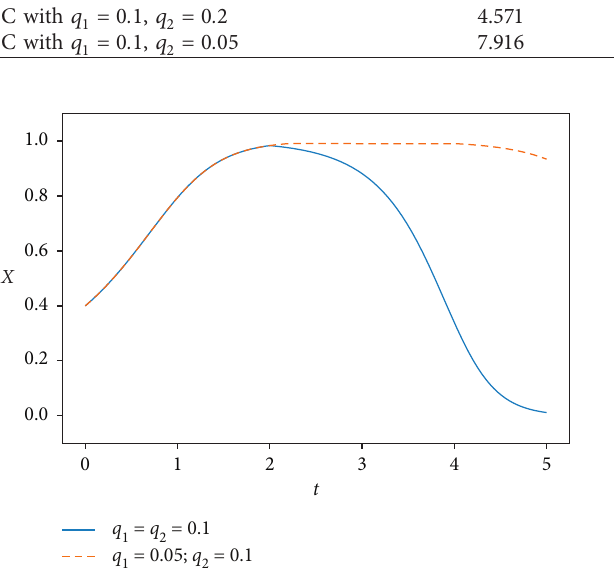
Figure 4: Cooperation rate x ( t ) with SC. Figure 5: Cooperation rate x ( t ) with